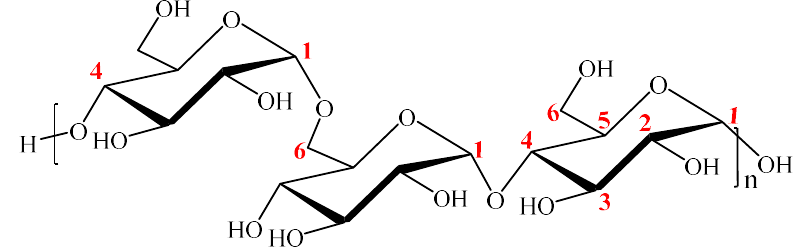
Figure 1. Chemical structure of pullulan.